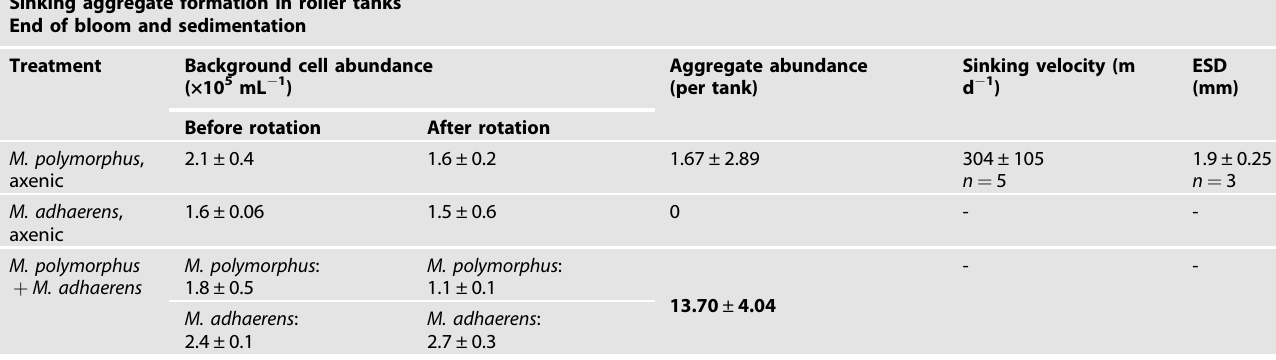
Table 4. Abundance, sinking velocity, and size of aggregates formed in roller tank experiments inoculated to higher total cell abundances (10 5 cells mL − 1 ). Sinking aggregate formation in roller tanks End of bloom and sedimentation